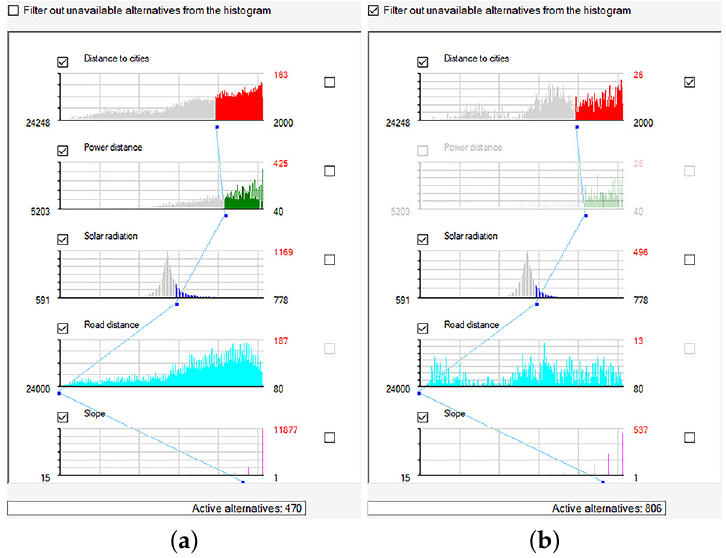
Figure 4. Different views of the threshold adjustment panel: ( a ) non-filtered view, where, for each criterion, all alternatives conforming to the threshold value for that particular criterion are drawn; ( b ) filtered view, where only alternatives conforming to all the thresholds are drawn, with one criterion ( Power distance ) discarded (equivalent to setting the threshold for that criterion to C min ) and another criterion ( Distance to cities ) selected as the criterion to be automatically adjusted, C resp . Red numbers in the upper right corner of each histogram denote the number of alternatives with a given value.